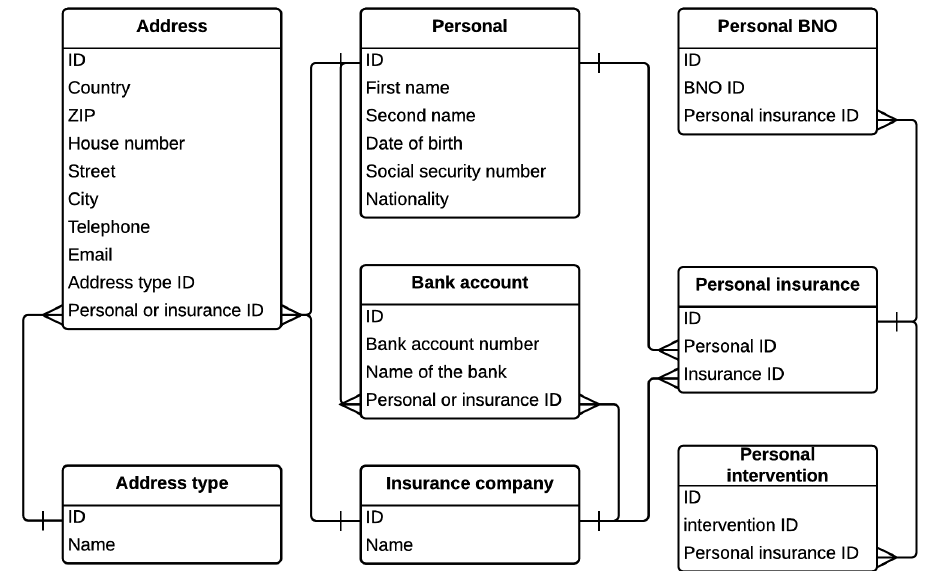
Figure 1. Example f or a traditional (relational) data stora ge structure